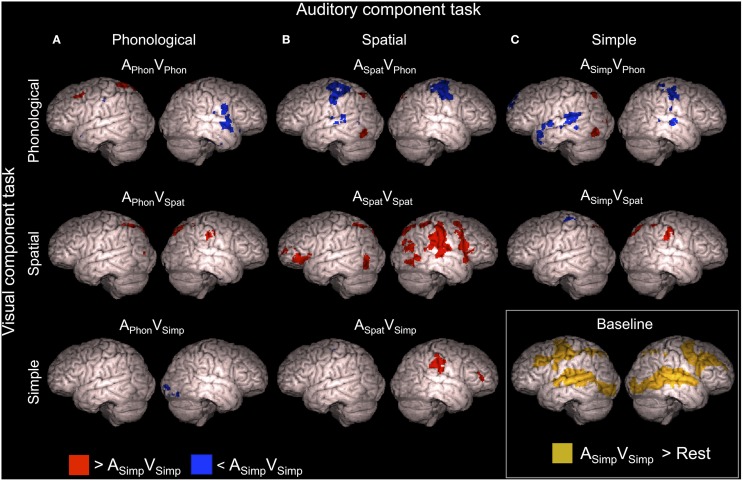
Brain activity during dual tasks in relation to the baseline dual task. Areas showing significant (Z > 2.3, cluster corrected P < 0.05) activity in relation to the ASimpVSimp dual task (simultaneous speaker-gender and font-shade discrimination task) used as the baseline. Dual tasks including the (A) auditory phonological, (B) auditory spatial, and (C) auditory simple component tasks compared with the baseline dual task. Dual tasks including the visual phonological, visual spatial and visual simple component tasks compared with the baseline dual task are shown in top, middle and bottom rows, respectively. Brain activity during the ASimpVSimp dual task in relation to brain activity during the resting periods is shown in the right bottom corner. Cortical activations are superimposed from 10 mm under the cortex on surface of rendered brain images.